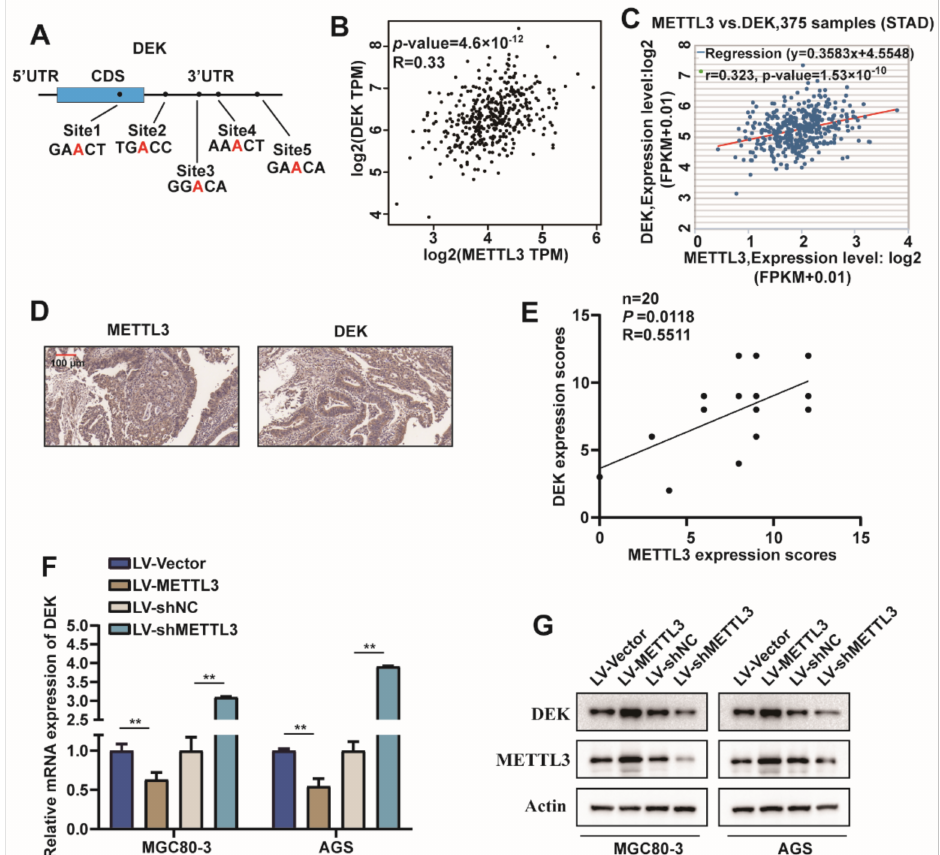
Figure 3. METTL3 regulated DEK expression in GC. ( A ) DEK m6A modification site prediction pattern map predicted by m6A2Target and SRAMP database (Both pre-mRNA genomic sequences (with introns) and mature mRNA sequences (containing 3- and 5-terminal non-coding sequences) of DEK were predicted at the SRAMP site. Site 1 was not predicted from the pre-mRNA genome sequence). ( B ) The GEPIA database predicts the correlation of METTL3 with DEK expression. ( C ) The ENCORI website predicts METTL3 in association with DEK expression. ( D ) Representative images of METTL3 and DEK immunohistochemical staining in tumor sections from the same patient. ( E ) The graph shows the correlation of METTL3 with DEK IHC scores and gives the Pearson correlation coefficient (R), p -value, as well as simple numbers ( n ) in the upper corner. ( F , G ) METTL3 was overexpressed or knocked down in MGC80-3 and AGS cells, DEK mRNA levels were detected by qPCR, and protein levels were detected by Western blot ( n = 3, **: p <